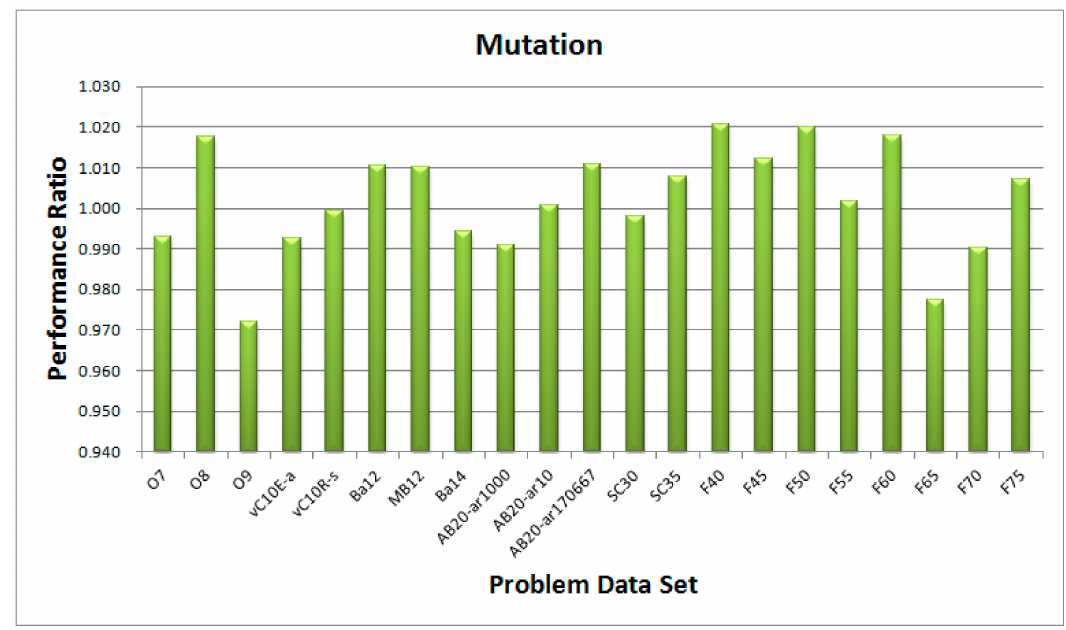
Figure 10. Performance ratio between MUT_M2 and MUT_M1 for